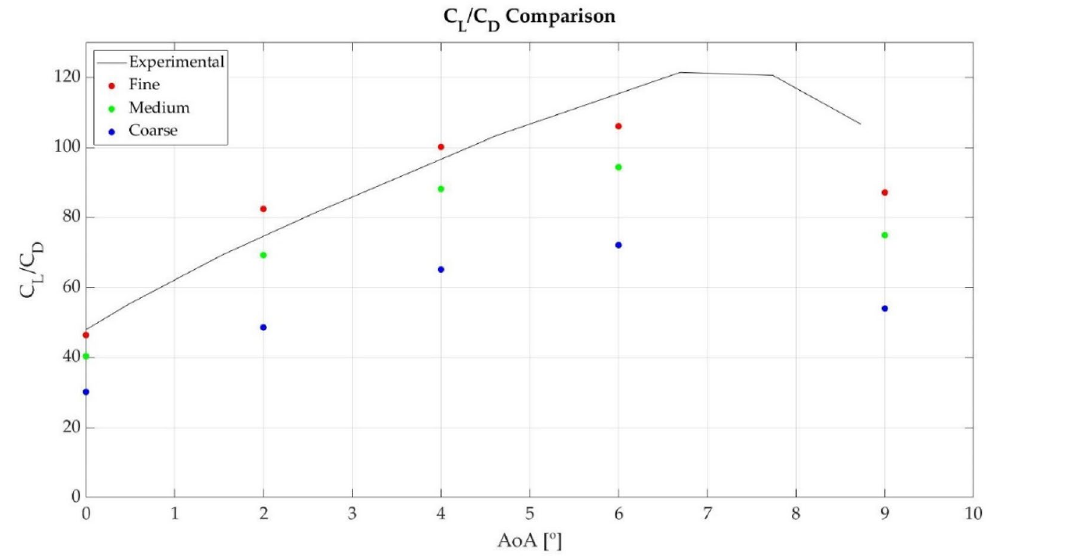
Figure 2. Lift-to-drag ratio comparison of the three generated meshes and the experimental data obtained by Timmer 26 .